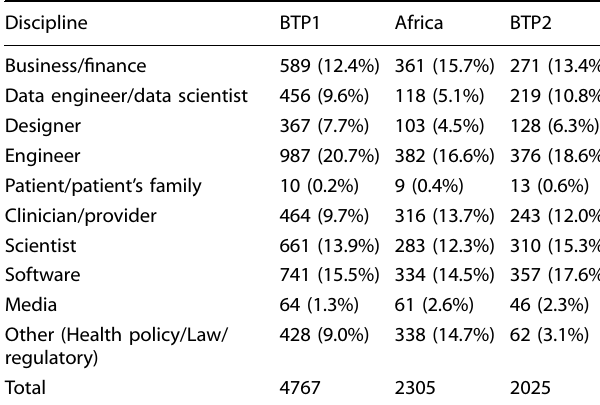
Table 2. Number of applicants per discipline per